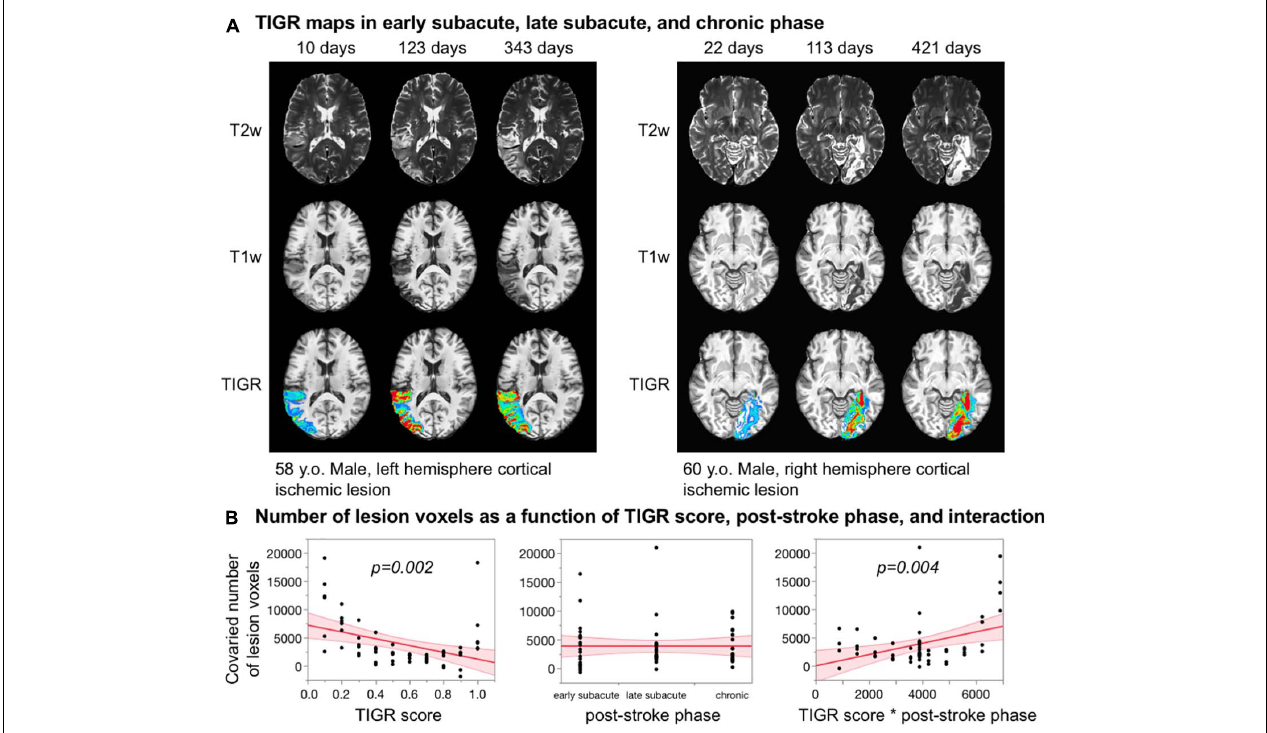
FIGURE 6 | (A) Feasibility of quantifying tissue integrity gradation via T2w T1w ratio (TIGR) in early subacute, late subacute, and chronic phases post-stroke in two participants. (B) The number of voxels in each TIGR bin decreases with increasing TIGR score, does not relate with post-stroke phase, but depends significantly on the interaction between TIGR and post-stroke